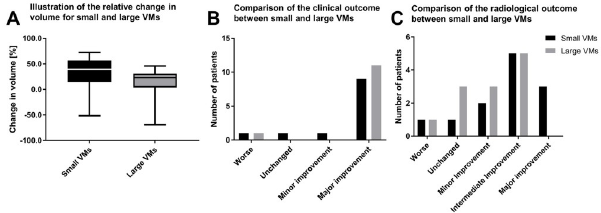
Fig 2. Comparison of small and large VMs. For smaller venous malformations, there was a broad spectrum of therapy response, ranging from a near cue up to a considerable increase in size (A). For larger venous malformations, the range in therapy response was comparatively smaller. Neither the clinical outcome (B), nor the radiological outcome (C) was significantly different between small and large